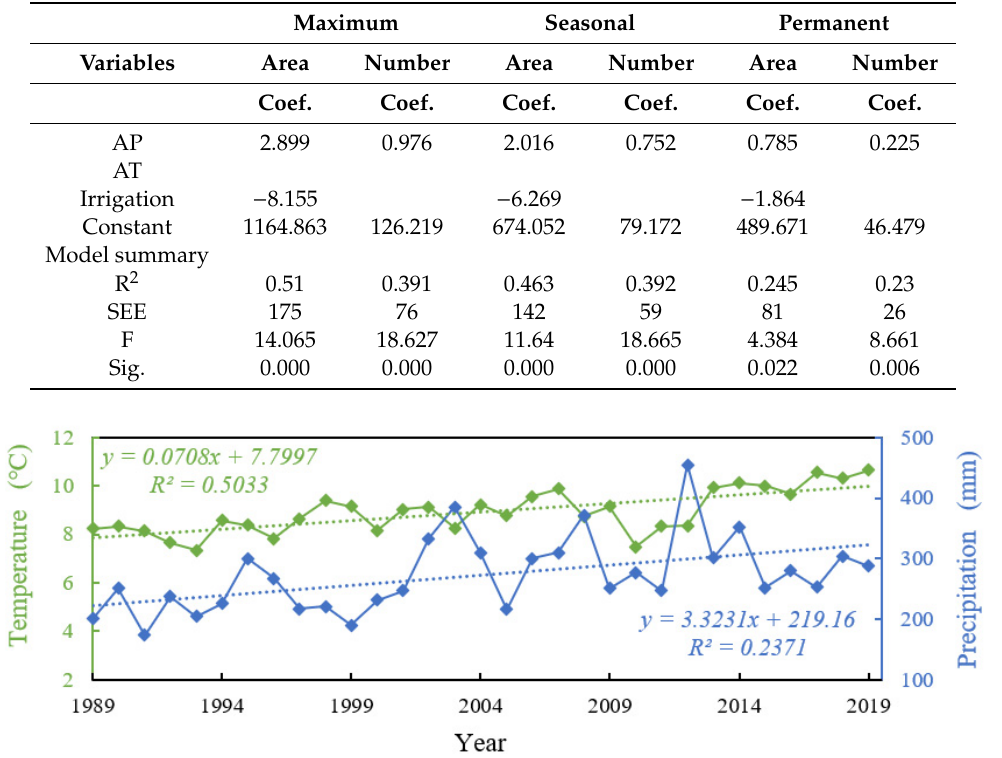
Figure 11. The trend of an irrigation area in the Hetao Plain from 1989 to 2018. Table 4. Multiple linear regression analyses of the water body area and water body number with climatic and anthropogenic driving factors in the Hetao Plain. The six dependent variables are maximum water body area, maximum water body number, year-long water body area, year-long water body number, seasonal water body area, and seasonal water body number. AP and AT are the Hetao Plain annual cumulative precipitation and annual average temperature respectively, the three dependent variables are AP, AT, and Irrigation. R 2 is the proportion of variance in the dependent variable, which can be explained by the selected explanatory variables. SEE is the standard error of the estimate. F and Sig. are the F-statistic and the p-value associated with it. For each linear regression, the variables were statistically significant (P < 0.05).